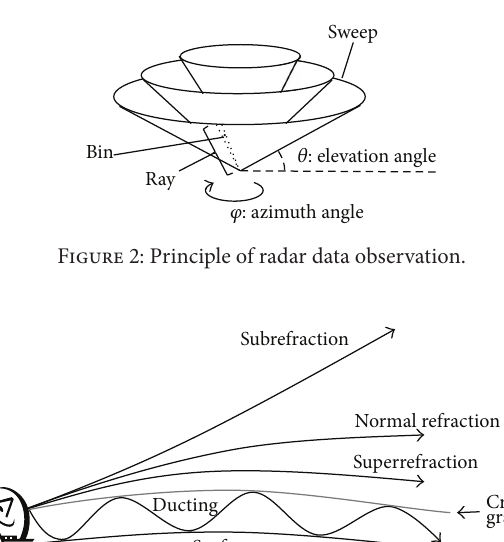
are preprocessed data unlike uncorrected reflectivity data in which ground echoes are removed from the raw data